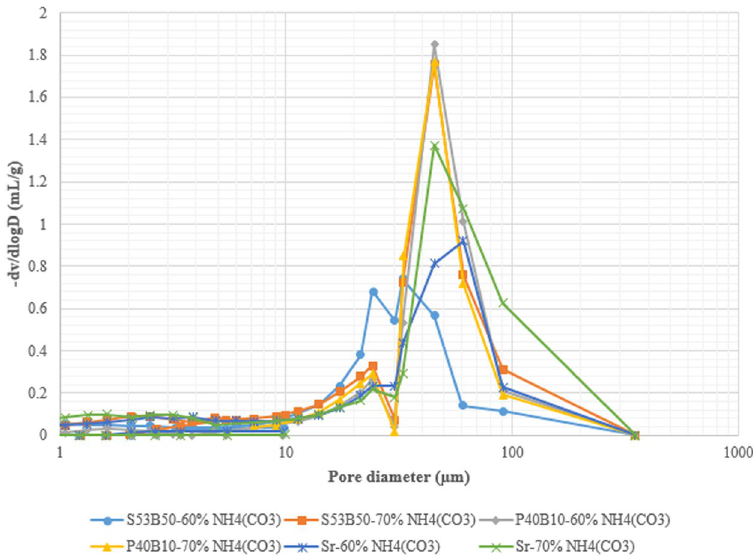
Figure 11. Pore size distribution of the glass scaffolds at different NH 4 (HCO 3 )